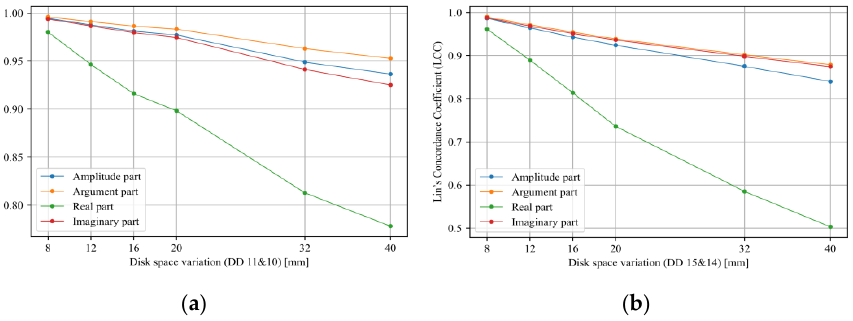
Figure 14. Feature variations based on the severity of the DSV fault in different locations for extracted by the LCC index: ( a ) DSV in DD 11 and 10 ( b ) DSV in DD 15 and 14.